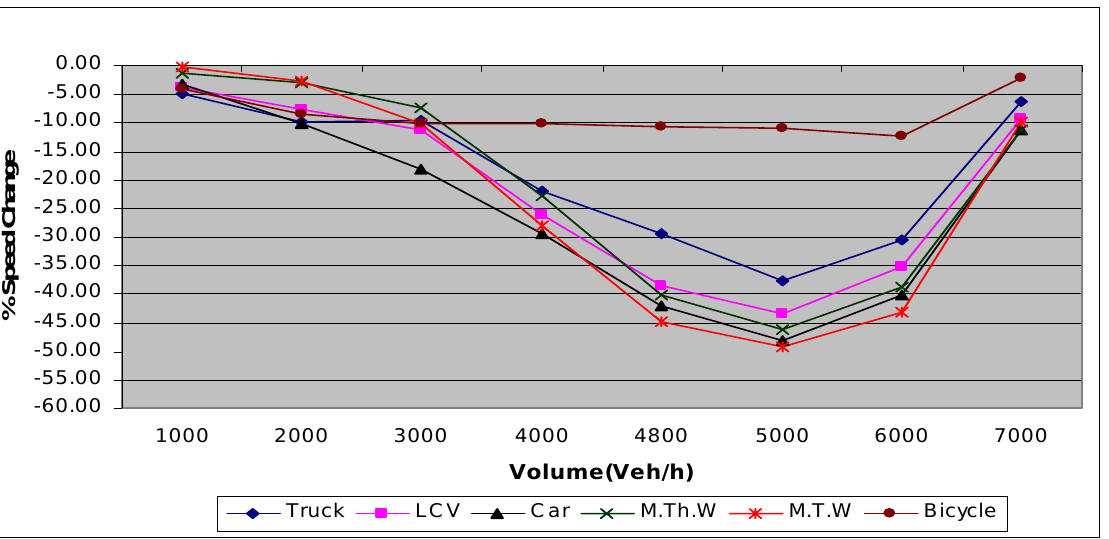
Figure 11. The rate of reduction in speeds of other categories vehicles due to provision of exclusive bus